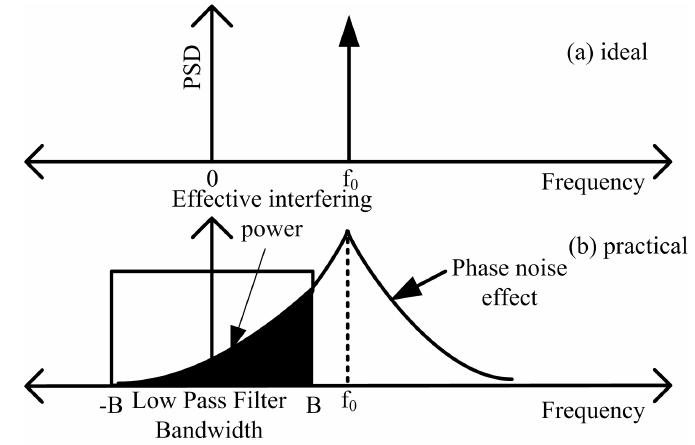
Figure 5. ( a ) Spectrum of an ideal oscillator; ( b ) spectrum of a practical